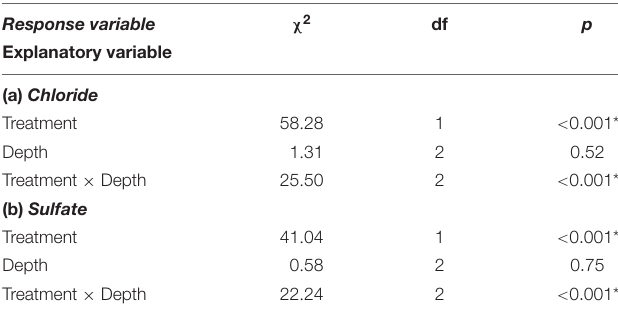
TABLE 2 | Analysis of deviance for beta regression models relating subsurface salt content of the platform substrate to treatment (mussel-removal vs. control benches) and depth layer (0–5, 5–10, and 10–15 mm).